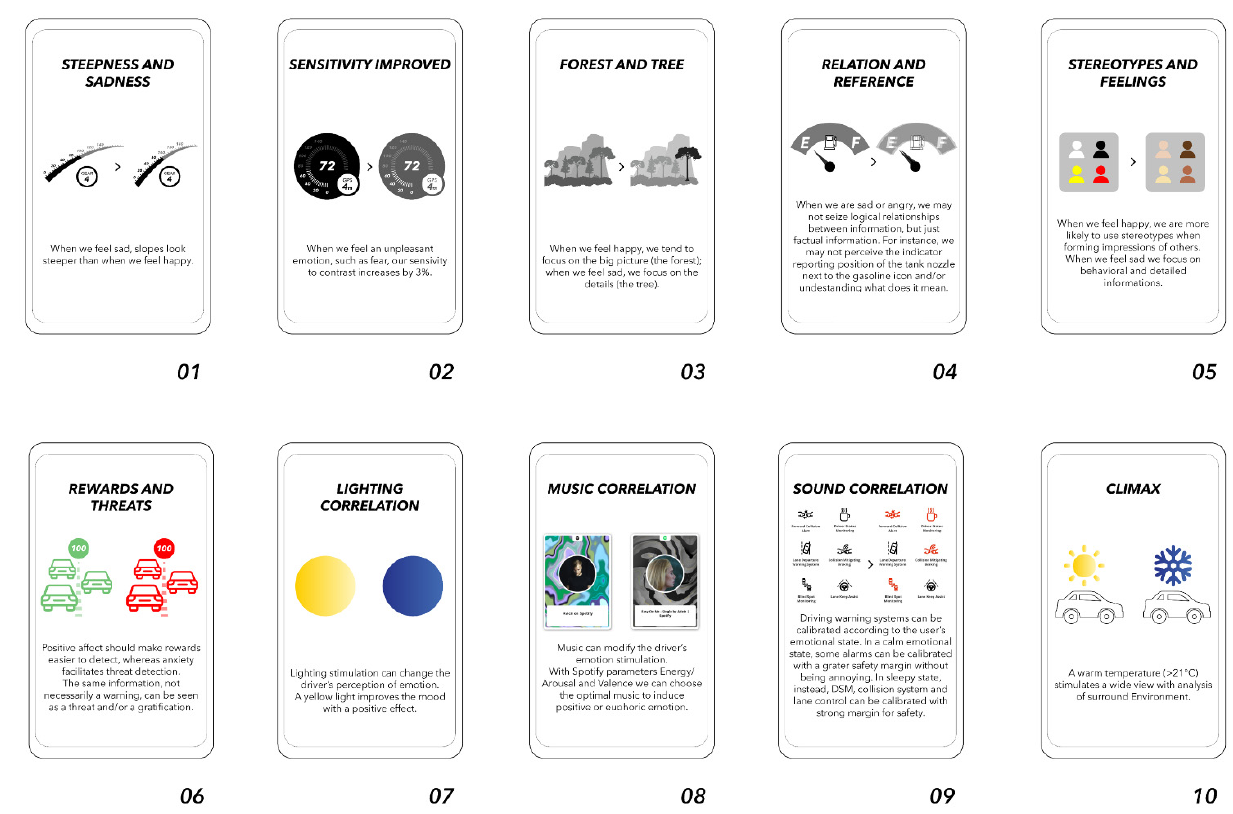
Figure 4. Cards defined for the automotive use case.